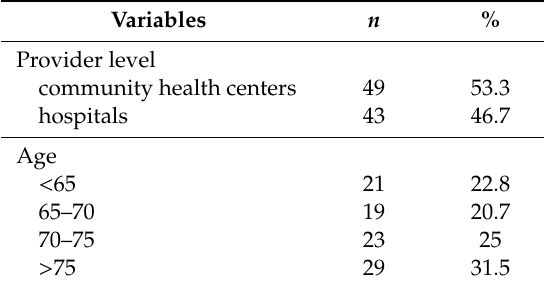
Table 1. Summary statistics of sample hypertension